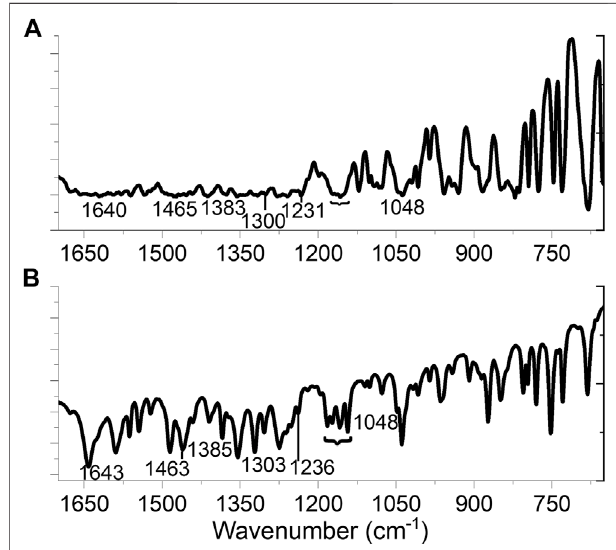
FIGURE 2 | IR spectrum of PEDOT:PSS-graphene-organotin complex fi lms. (A) Organotin complex without the substituent and (B) with the chloride